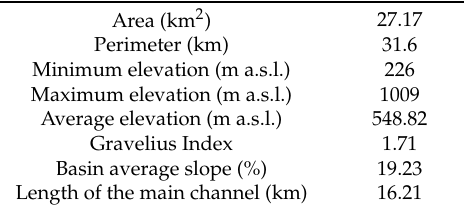
Table 1. Carapellotto basin main characteristics.